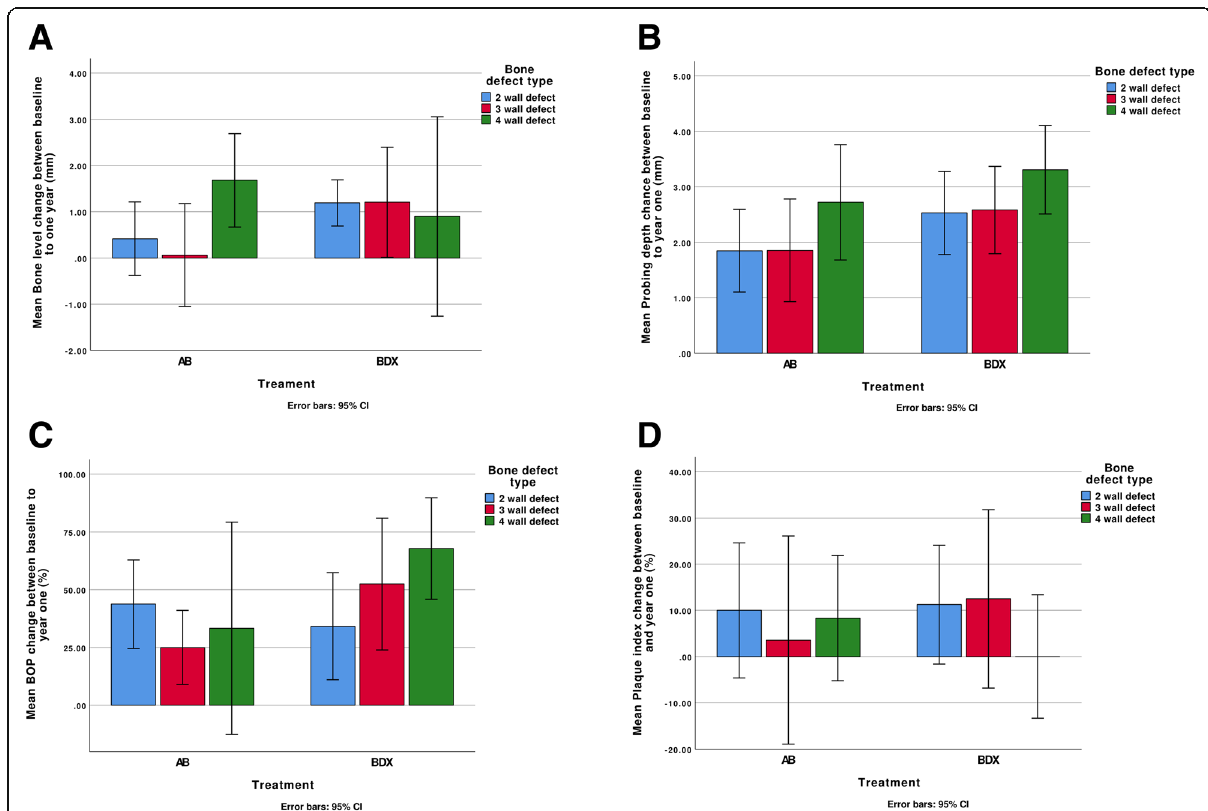
Fig. 4 a Mean bone level change between baseline and year 1 (AB, autologous bone; BDX, bovine-derived xenograft) in relation to defect characteristics (mean values and error bars 95%). b Mean PPD change between baseline and year 1 (AB, autologous bone; BDX, bovine-derived xenograft) in relation to defect characteristics (mean values and error bars 95%). c Mean BOP change between baseline and year 1 (AB, autologous bone; BDX, bovine-derived xenograft) in relation to defect characteristics (mean values and error bars 95%). d Mean plaque index change between baseline and year 1 (AB, autologous bone; BDX, bovine-derived xenograft) in relation to defect characteristics (mean values and error bars